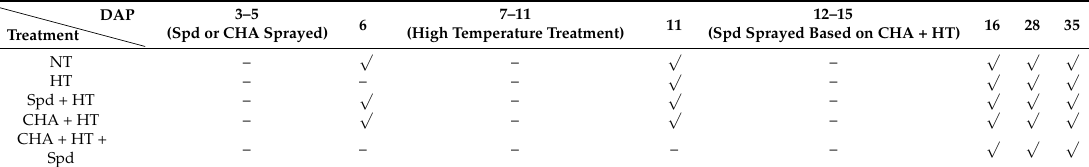
Table 2. Sampling time points of different treatments during development of rice seed. Treatment